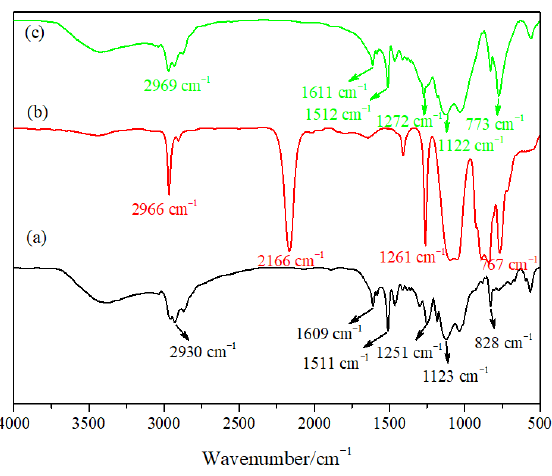
Figure 2. Infrared spectra of materials: ( a ) epoxy resin particles, ( b ) hydrogenated silicone oil (PMHS) and ( c ) hydrophobic gel.